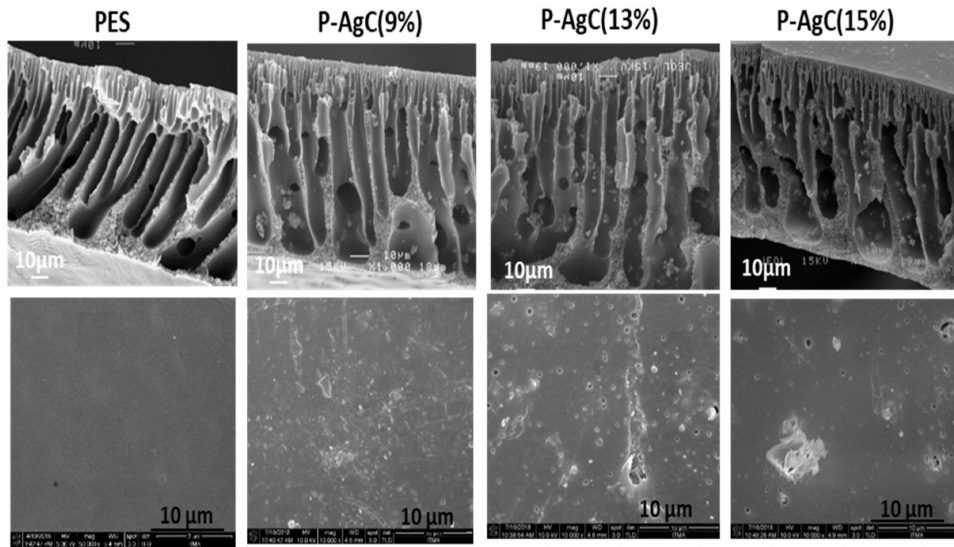
Figure 3. SEM cross-section images and FESEM surface images of PES net, P-AgC (9%), P-AgC (13%), and P-AgC (15%) composite